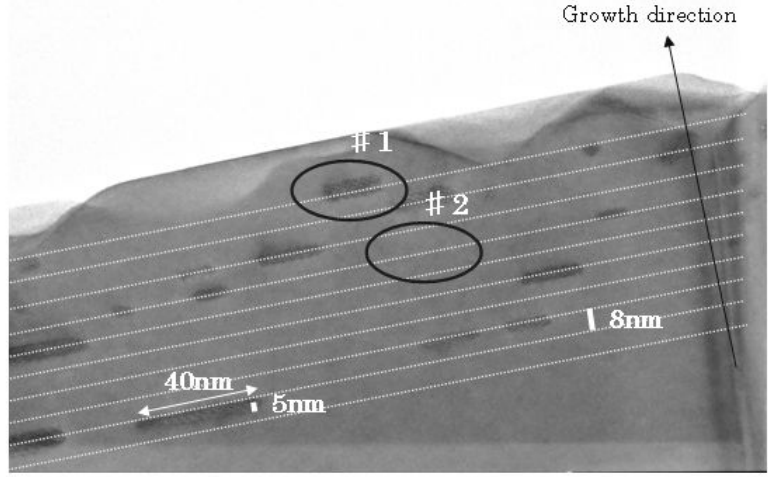
Figure 13. Aligned CrN nanoclusters in GaN grown by RF-MBE imaged by cross-section TEM. Reproduced with permission from Reference [95].